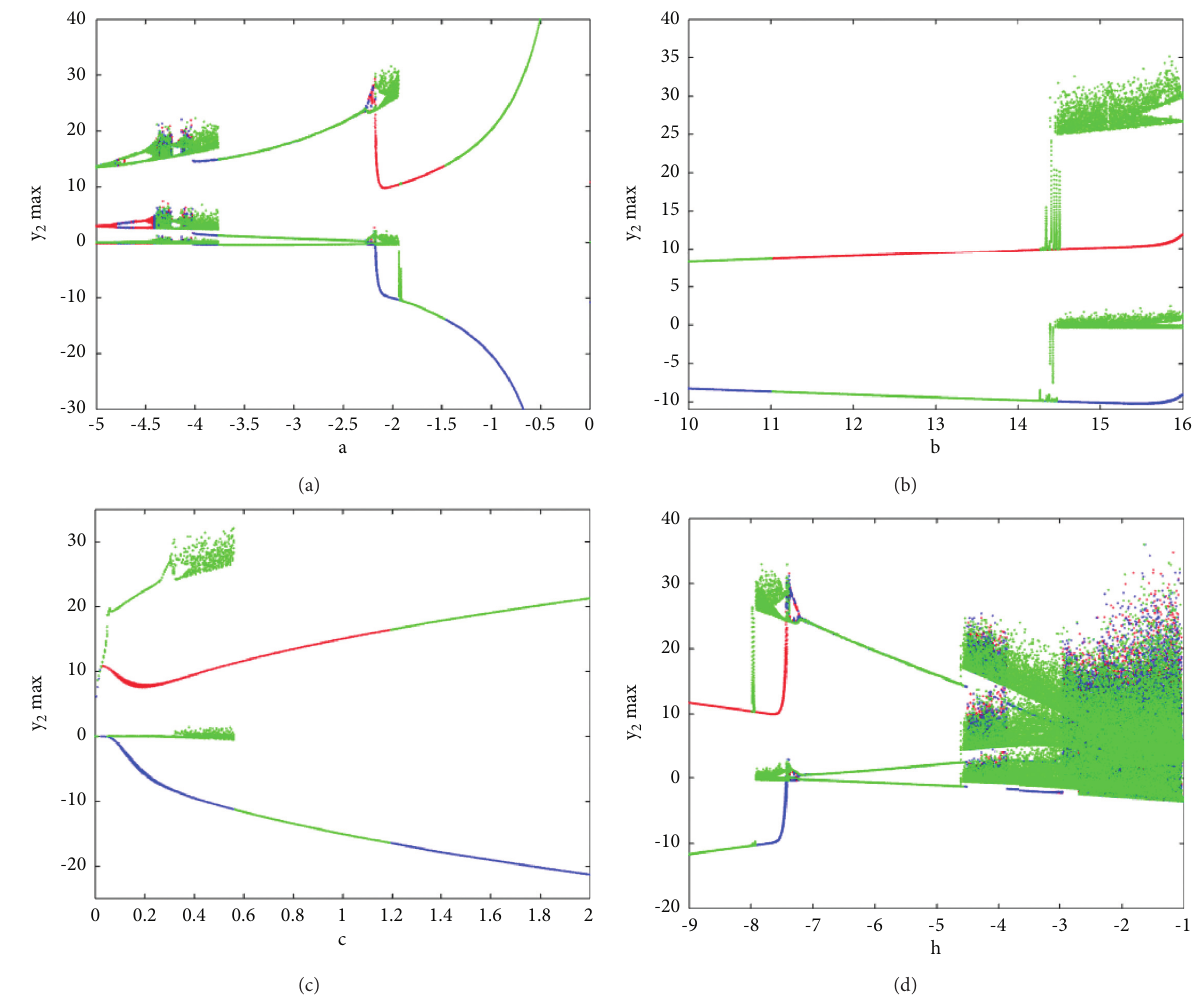
Figure 13: The bifurcation diagrams of the integer-order Matouk’s system with varying one parameter and fixing the others according to the set A and using initial conditions ( 0 . 01 , 0 . 01 , 0 . 01 , 0 . 01 ) (green domain), ( 2 . 7 , 10 . 6 , 15 , 0 . 0001 ) (red domain), and (− 2 . 7 , − 10 . 6 , 15 , 0 . 0001 ) 2 (blue